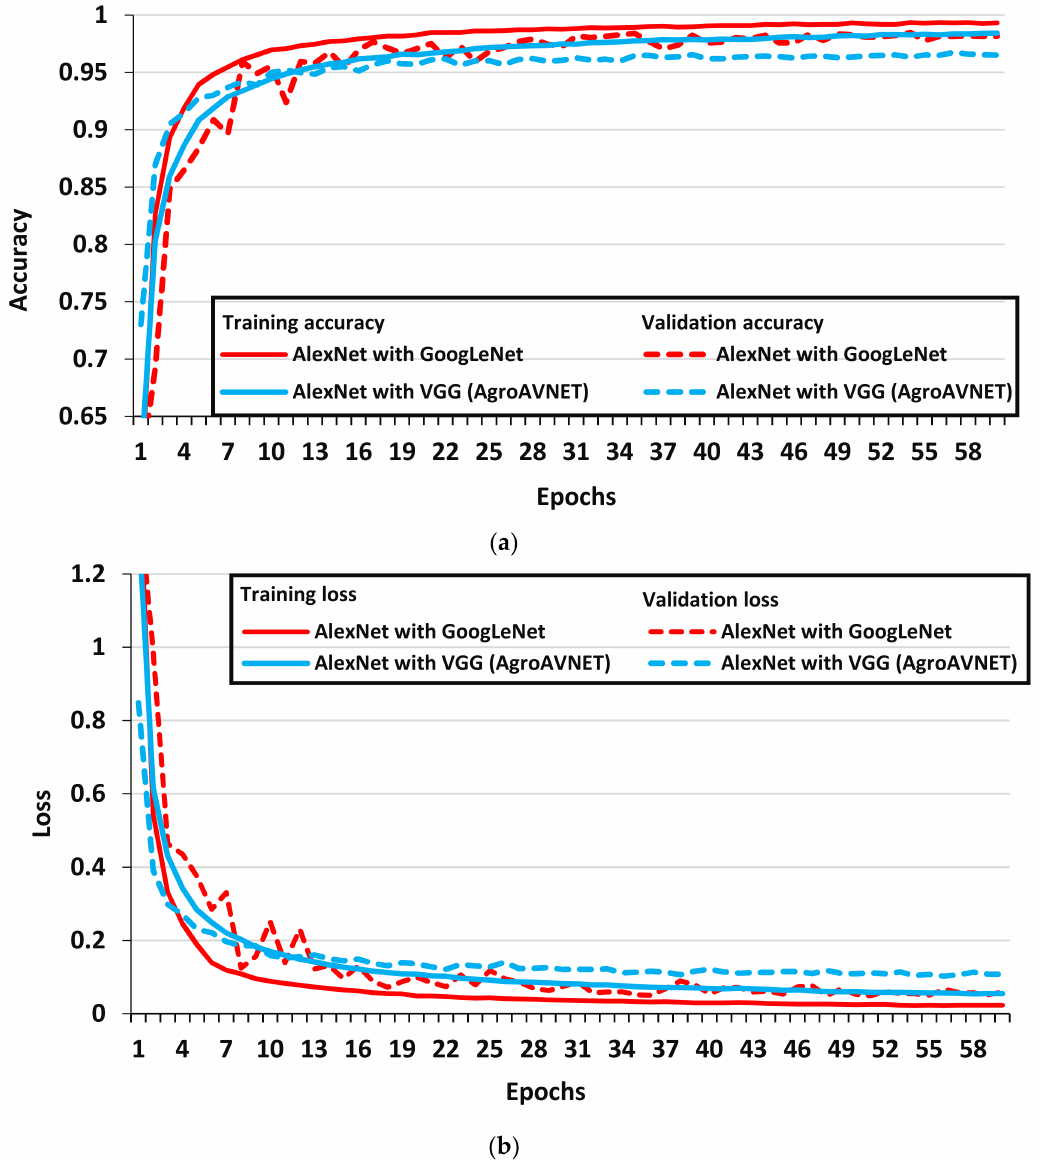
Figure 6. Performance plots of cascaded / hybrid versions of CNN architectures. ( a ) Provides training and validation accuracy, ( b ) provides training and validation